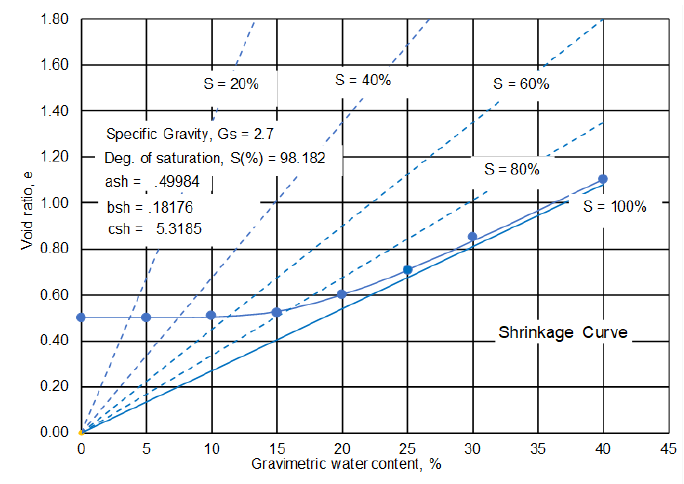
Figure 7. Graphical presentation of the shrinkage curve data and regression analysis results.